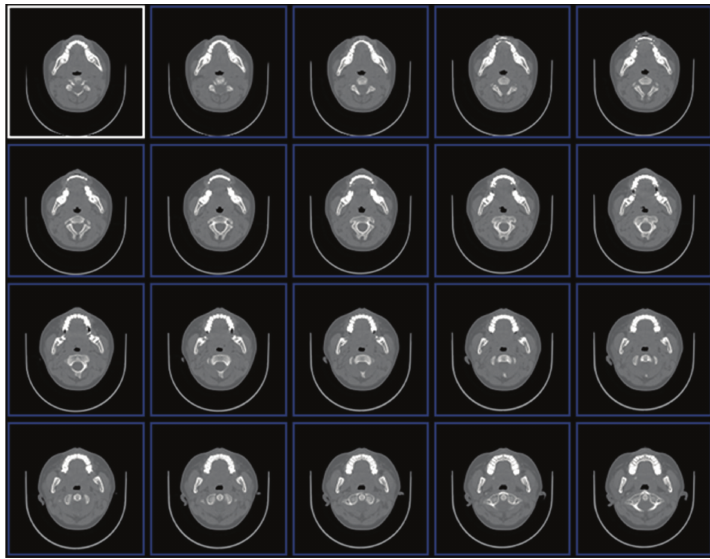
Figure 2: Part of the organized CT images in the top view.